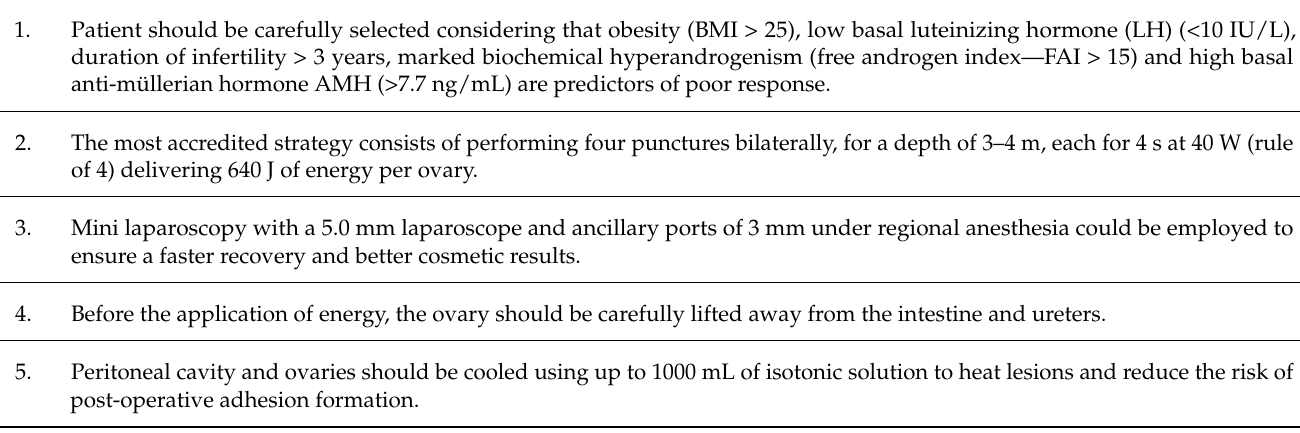
Table 1. Ovarian drilling: key factors to